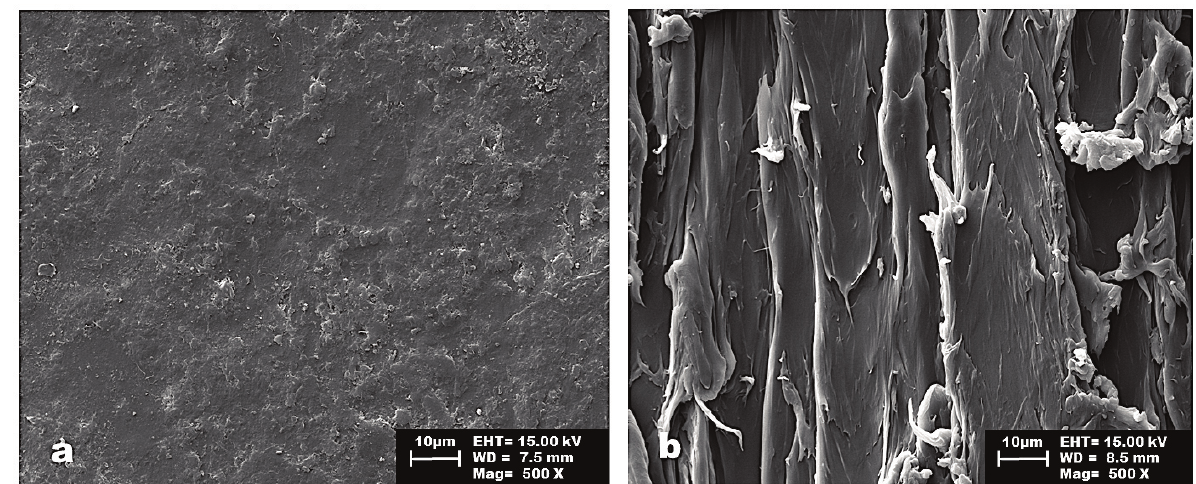
Fig. 6. PP/CF composites before (a) and after (b) sliding